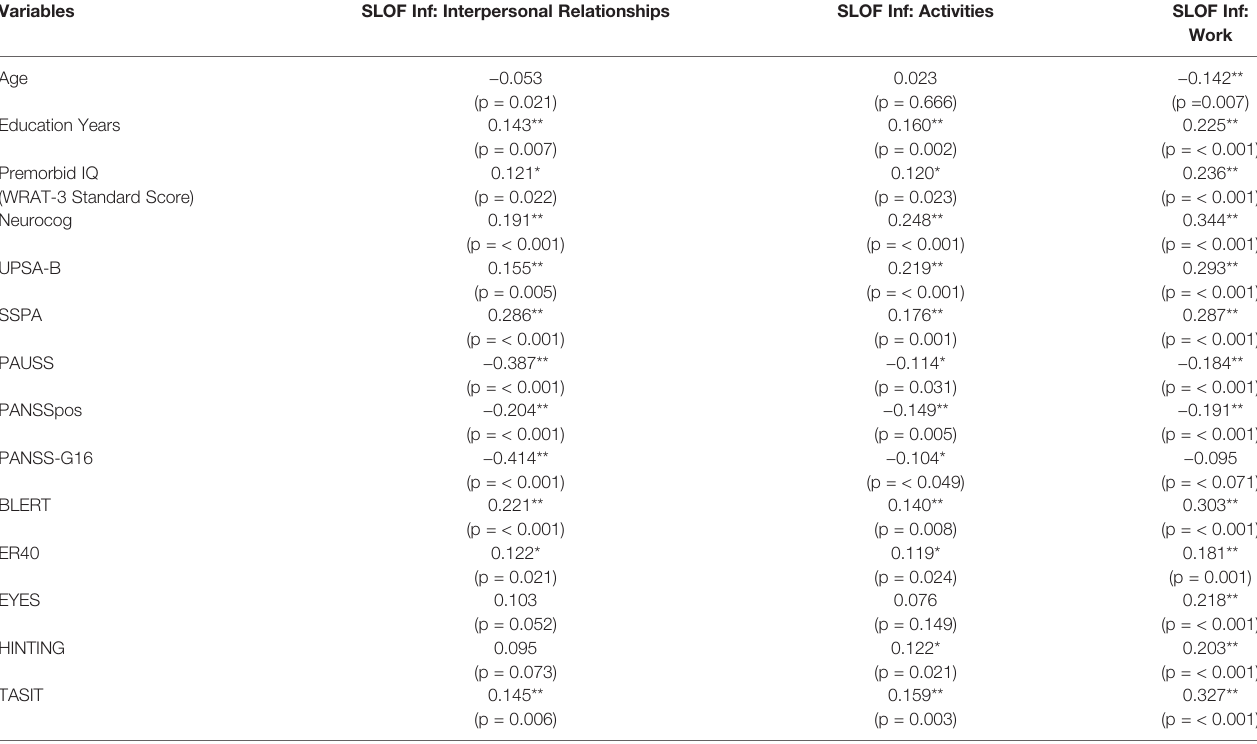
TABLE 2 | Correlations between SLOF scales and demographic, cognitive, clinical, and social cognitive variables.